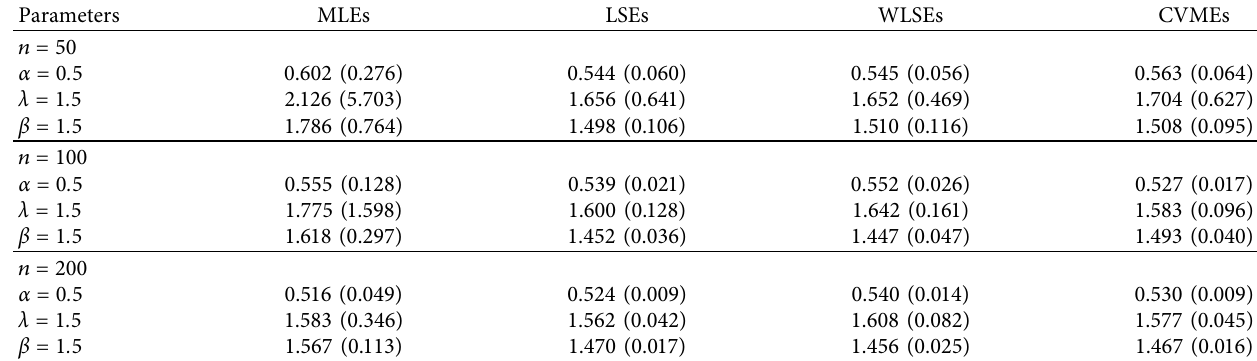
Table 3: The mean values and MSEs of the TIHLIW distribution.